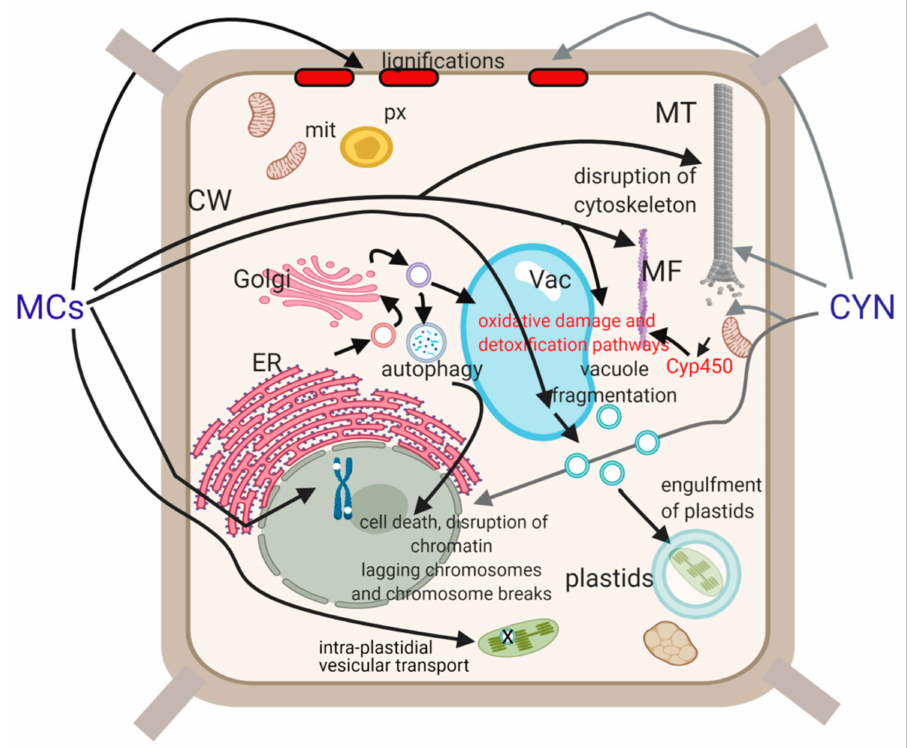
Figure 3. A summary of subcellular effects for microcystins (MCs) and cylindrospermopsin (CYN). Physiological alterations such as the detailed mechanisms of oxidative damage or inhibition of chloro- plast photosynthetic activity are not shown here. CW—cell wall, Cyp450—cytochrome monooxy- genase P450, MF—microfilament, mit—mitochondria, MT—microtubule, px—peroxisome, vac— vacuole. Image created with